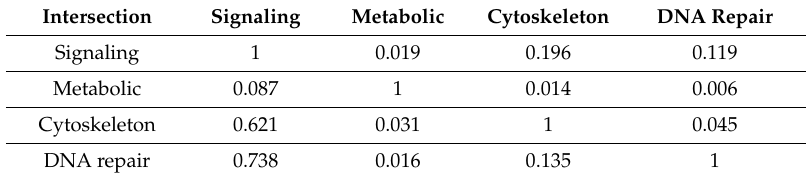
Table 1. Similarity coe ffi cients between gene compositions of di ff erent groups of molecular pathways.